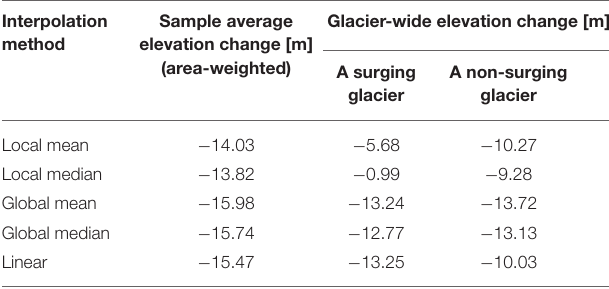
TABLE 1 | Comparison of glacier elevation changes of the 1,526 glaciers in west-central Greenland from 1985 to 2012 based on different void-interpolation